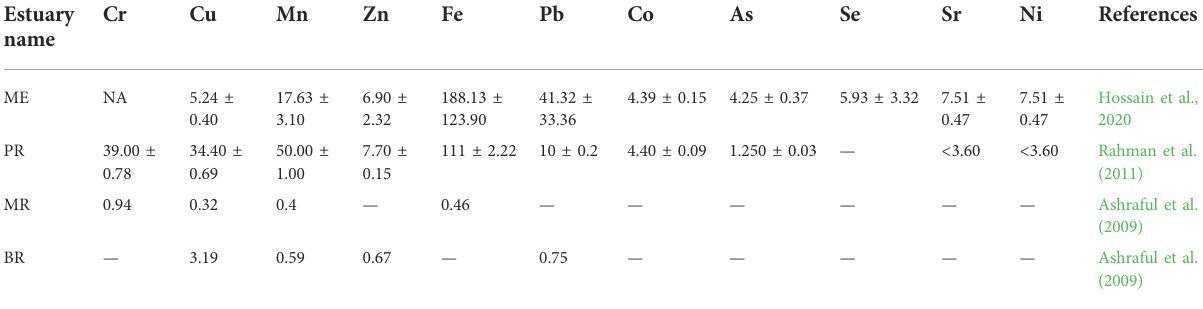
TABLE 3 Trace metal concentrations in water of different estuarine systems, Bangladesh. Estuary